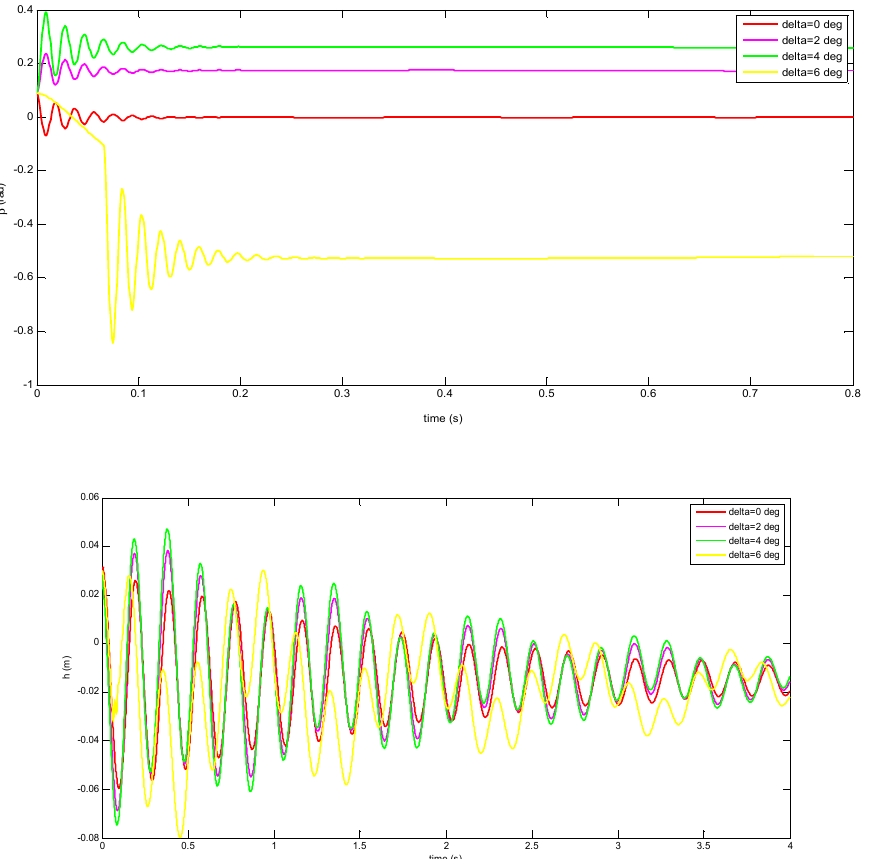
Figure 23. Time responses of alpha and beta and “h” in di ff erent freeplay in lower speed of flutter.